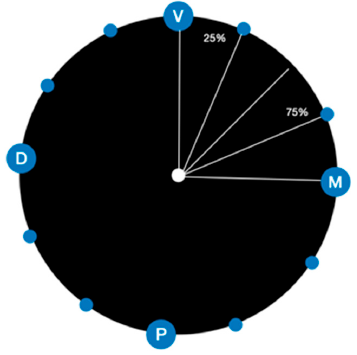
Figure 5. Scheme of reference points.